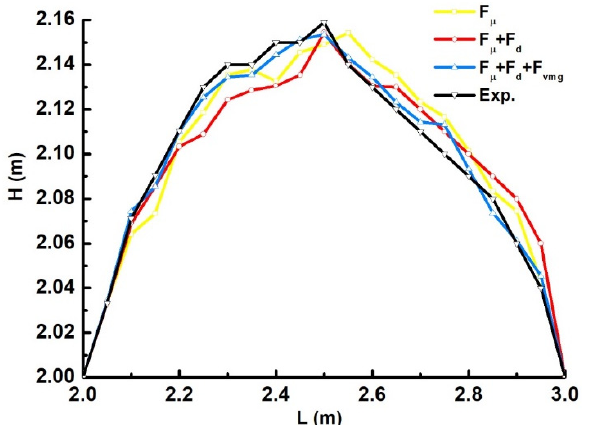
Figure 8. Boundary layer curves under di ff erent initiation modes displayed in Table 1.